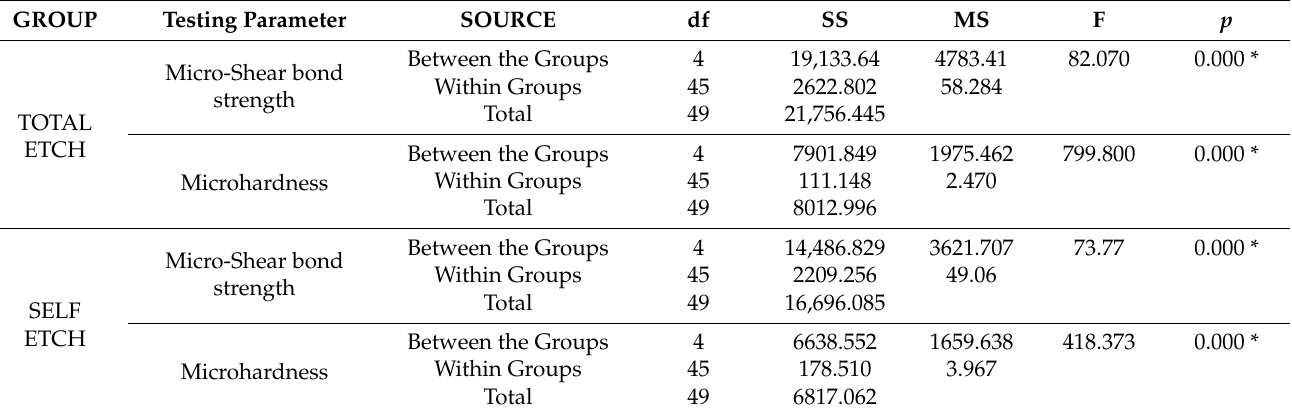
Table 3. One-way ANOVA analysis of different surface disinfection group for mean Micro-Shear bond strength and microhardness.